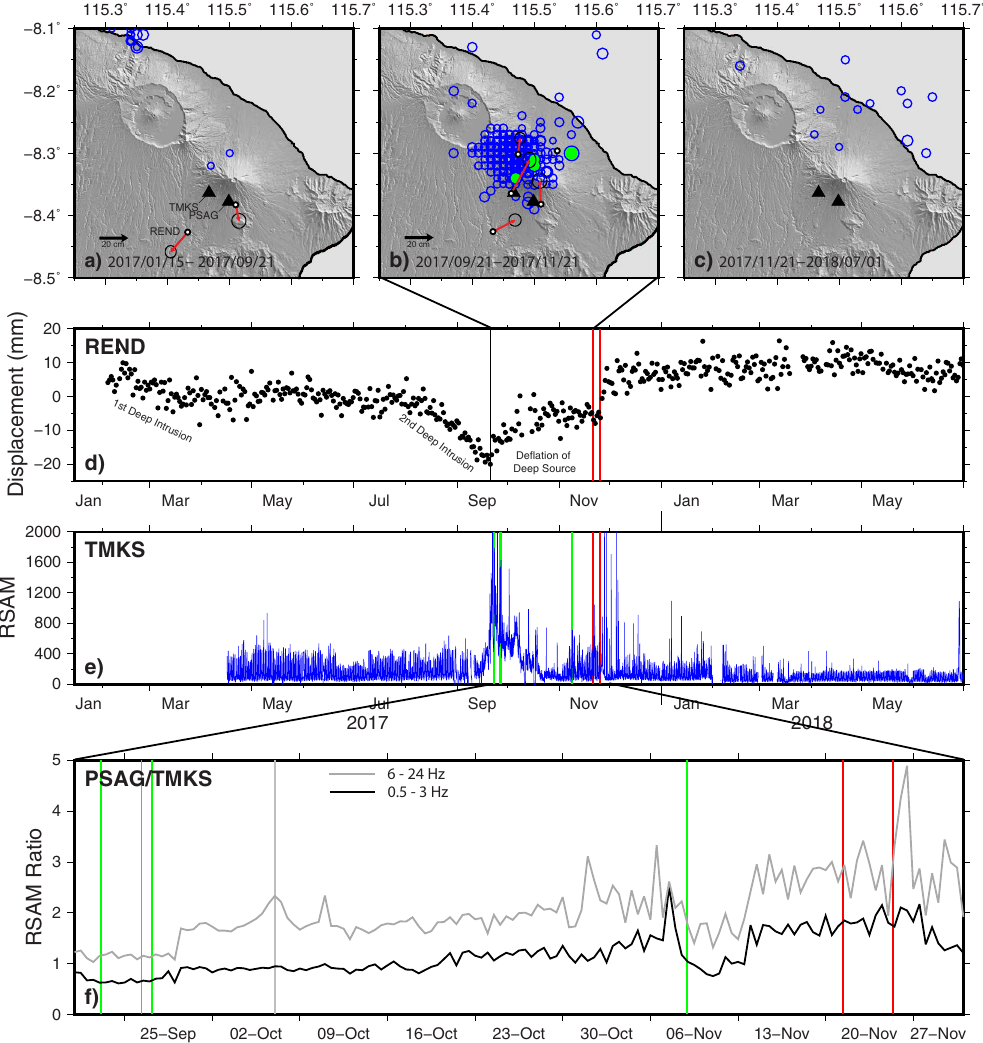
Figure 3. Regional BMKG Earthquake locations for ( A ) 2017/01/15 – 2017/09/21, ( B ) 2017/09/21 – 2017/11/21, and ( C ) 2017/11/21 – 2018/07/01. Earthquake circle size is scaled by magnitude (range M2.2 to M4.9). Locations are plotted from public data listed to two decimal places, accounting for the gridded appearance. M4 + events are colored green. GPS displacement vectors (small circle is station location: larger circle is approximate error ellipse) demonstrate ( A ) movement away from the volcano during deep inflation and ( B ) movement to the N and NE as a result of a combination of dike intrusion and deflation of a deeper source. No clear deformation source was seen in ( C ). ( D ) Detailed GPS time-series and ( E ) RSAM data (1 hour) for stations REND (North) and TMKS, respectively. ( F ) Frequency filtered RSAM (12 hour) ratios between seismic stations PSAG and TMKS, the two closest stations (4.0 and 5.0 km, respectively) to the Agung summit, which were operating continuously both before and during the seismic crisis. Both instruments are Mark Products L4 seismometers with a one-second period. The frequency bands 0.5–3 Hz (black) and 6–24 Hz (gray) are shown in order to remove a persistent cultural noise source at ~4–5 Hz. Both bands show a general increase in ratio over time approaching the eruption, after which the ratio began to decrease. Green lines in ( E ),( F ) represent times of M4 + earthquakes shown in ( B ). Red lines in ( D )–( F ) show timing of the phreatomagmatic eruption onset (21 November) and onset of larger explosions (25 November). The gray line in ( F ) shows the timing of a large steam emission visible at the summit on 7 October. The abrupt changes prior to this on 29 September are due to changes in analog telemetry. See text and Fig. 1 for other